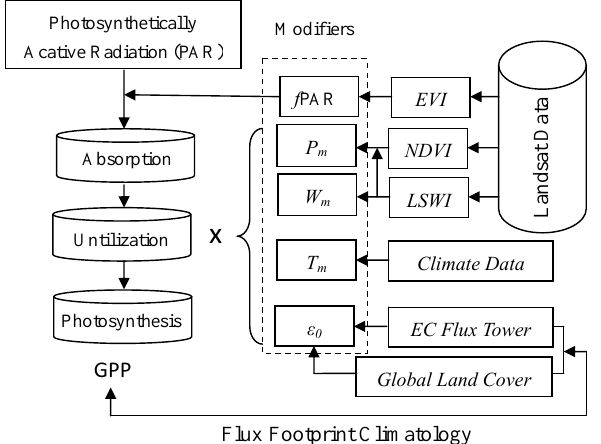
Fig. 2. Flow diagram of the major processing steps of the LANSAT- based GPP algorithm. The definitions of symbols and abbreviations are given in